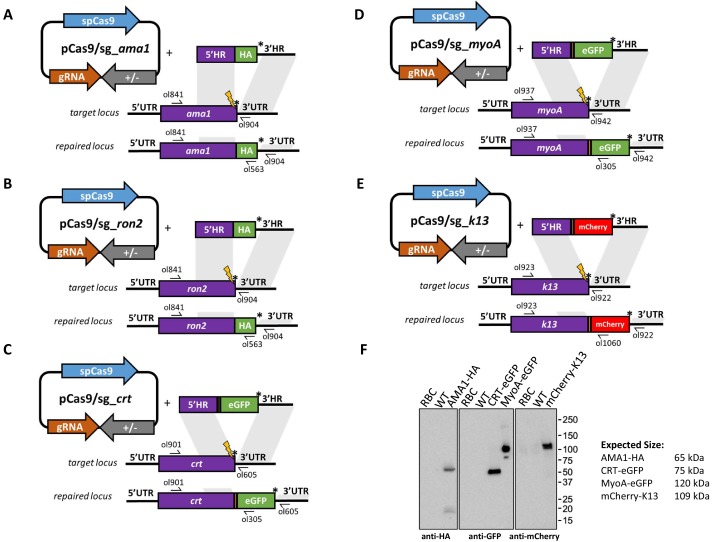
CRISPR-Cas9 tagging of P.knowlesi proteins.(A) Schematic of CRISPR-Cas9 strategy. C-terminal integration of the hemagglutinin (HA) tag into the target Apical membrane antigen (AMA1) locus via homologous recombination. Arrows indicating oligo positions for diagnostic PCRs. (B) C-terminal integration of HA tag into the target Rhoptry neck protein 2 (RON2 locus). (C) C-terminal integration of eGFP into the target Chloroquine Resistance Transporter (CRT) locus. (D) C-terminal integration of eGFP into the target Myosin A locus. (E) N-terminal integration of mCherry into the target Kelch13 (K13) locus. (F) Western blot showing expression of tagged proteins in P. knowlesi saponin-lysed schizonts separated by SDS-PAGE and immunoblotting with anti-HA, anti-GFP or anti-mCherry primary antibodies. Control samples are saponin-lysed red blood cells (RBC) and wild type parasite line. Expected sizes of bands are indicated. CRT runs faster than its expected band size as shown in P. falciparum previously. All primer pairs to generate PCR repair templates are shown inFigure 3—source data 1 and primer sequences are listed in Figure 5—source data 2.